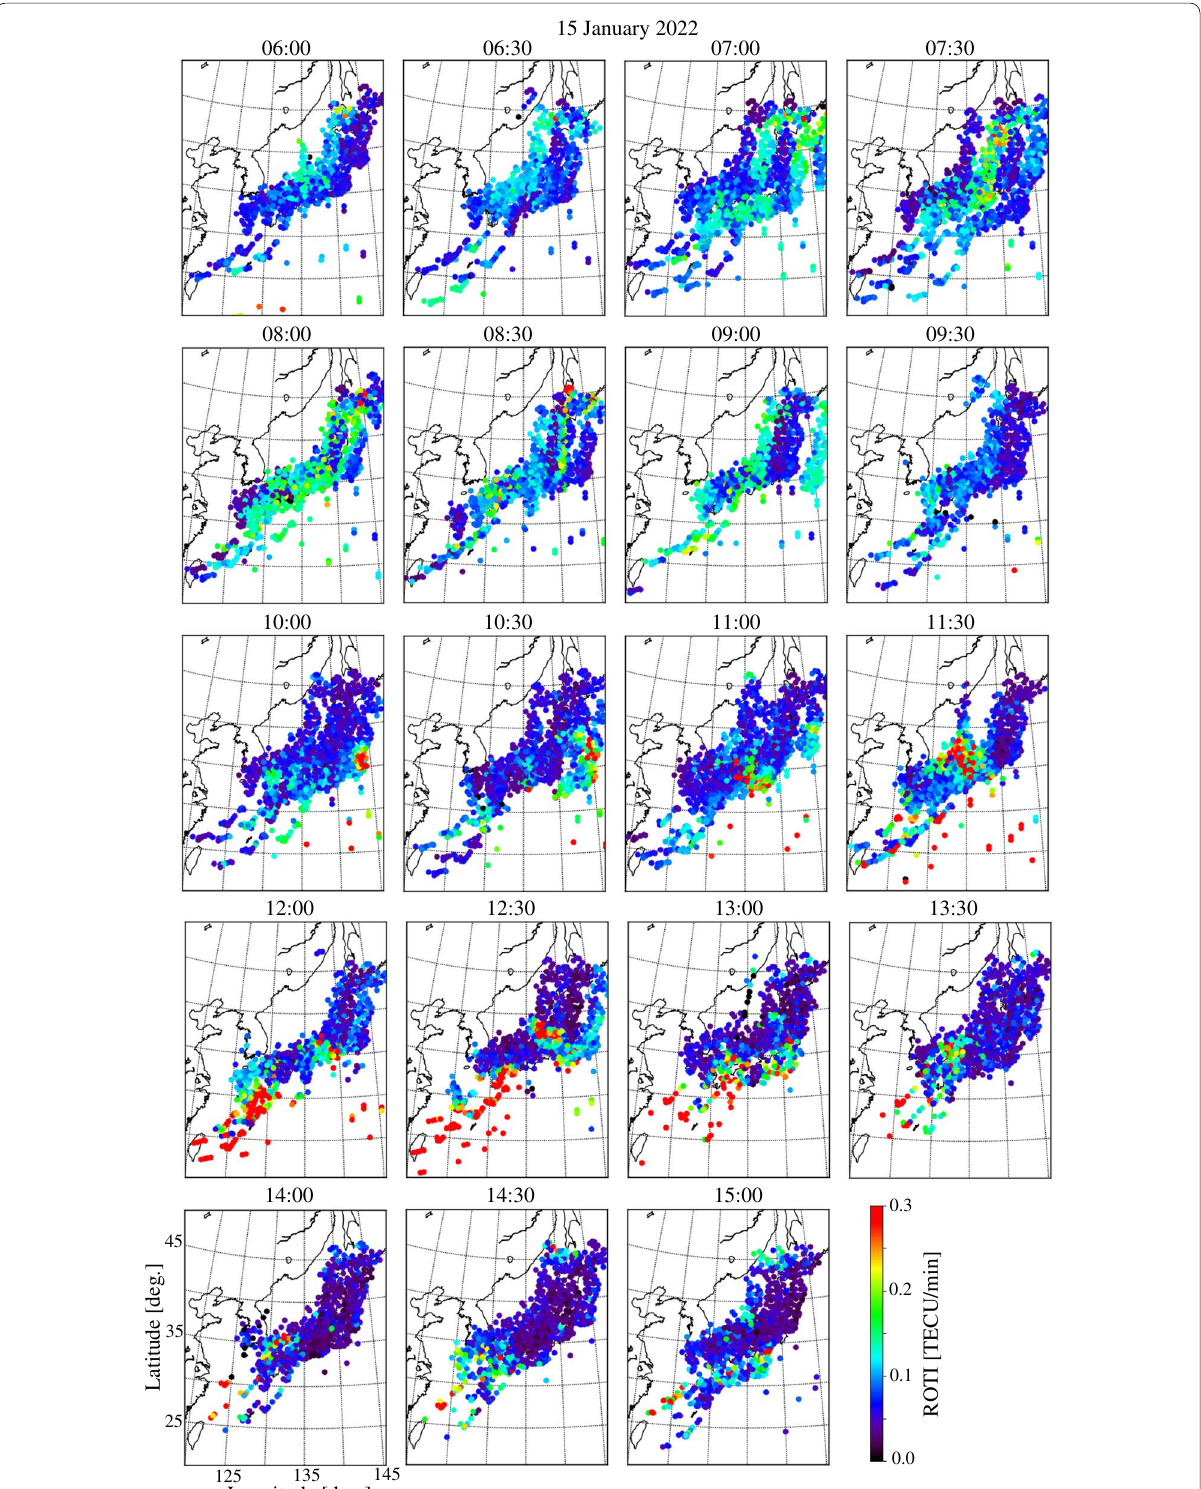
Fig. 4 ROTI maps from 0600 to 1500 UT (1500 to 2400 JST) on 15 January